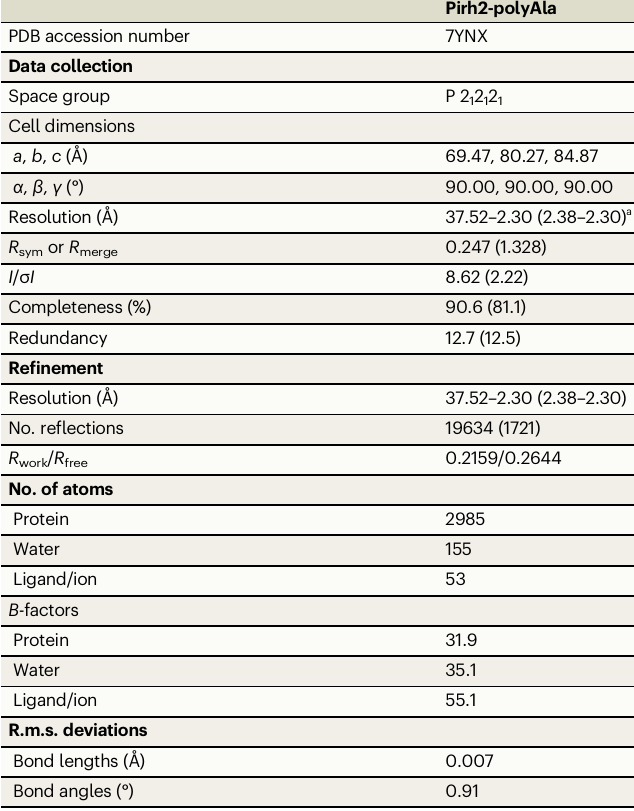
Table 1 | Data collection and re fi nement